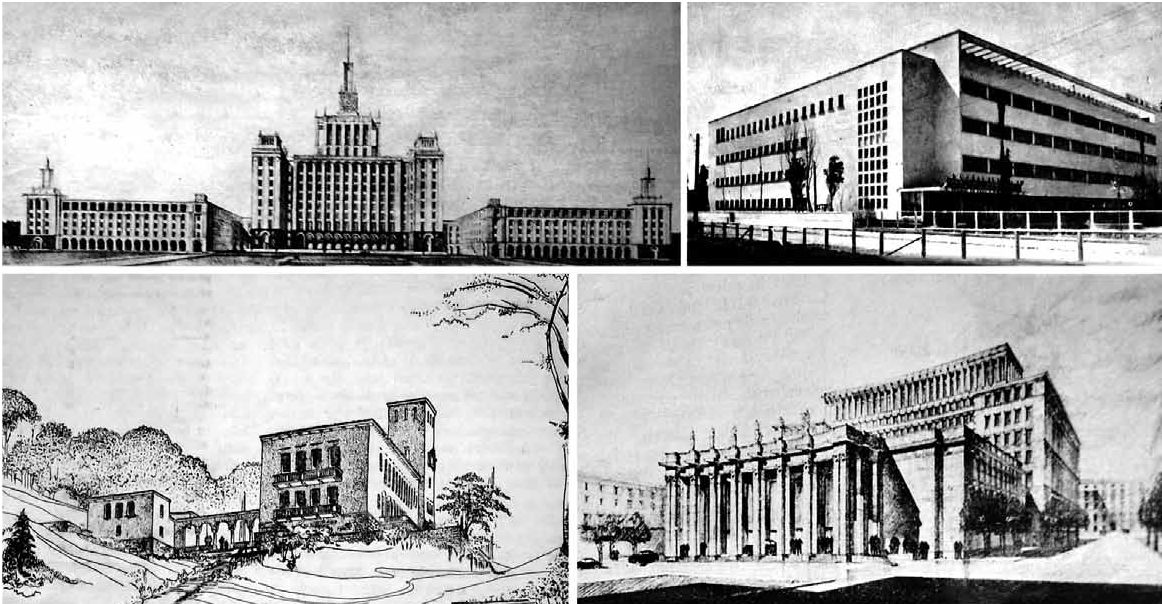
fig. 4. official Socialist realism (top left, Casa Scînteii) and its subversion through practice: Emilia Irza Hospital (G. Ionescu, top right), Hunedoara Sanatorium (H. Delavrancea, bottom left), Casa radiofoniei (T. ricci, bottom right). Sources: Arhitectura, 1952, 1–2: 8–9; Arhitectura, 1952, 8: 10; Arhitectura, 1952, 9–10: